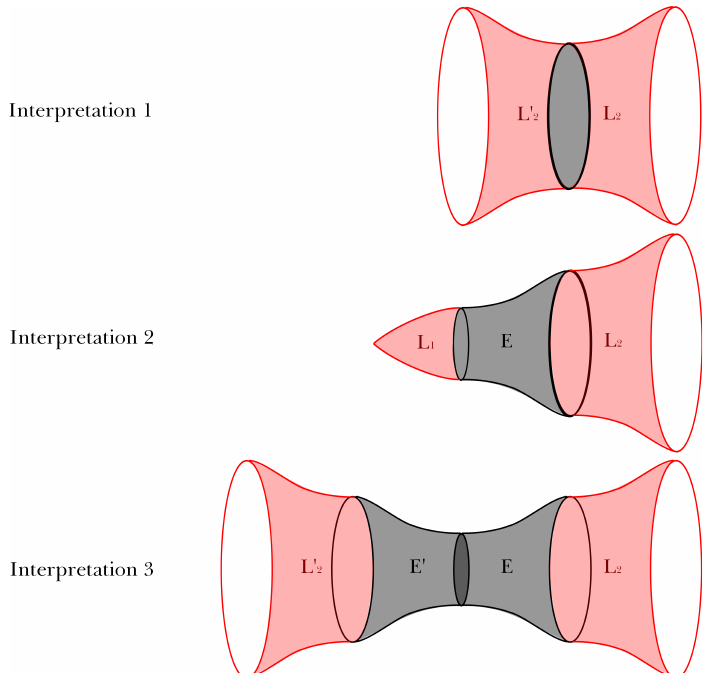
Figure 6. Possible interpretations of Euclidean wormholes [24]. Top: A collapsing universe is bounced (Interpretation 1). Middle: A small universe tunnels to a large universe or one contracting and one expanding universes are created (Inter- pretation 2). Bottom: Two entangled universes are created or a contracting universe is bounced to an expanding universe (Interpretation